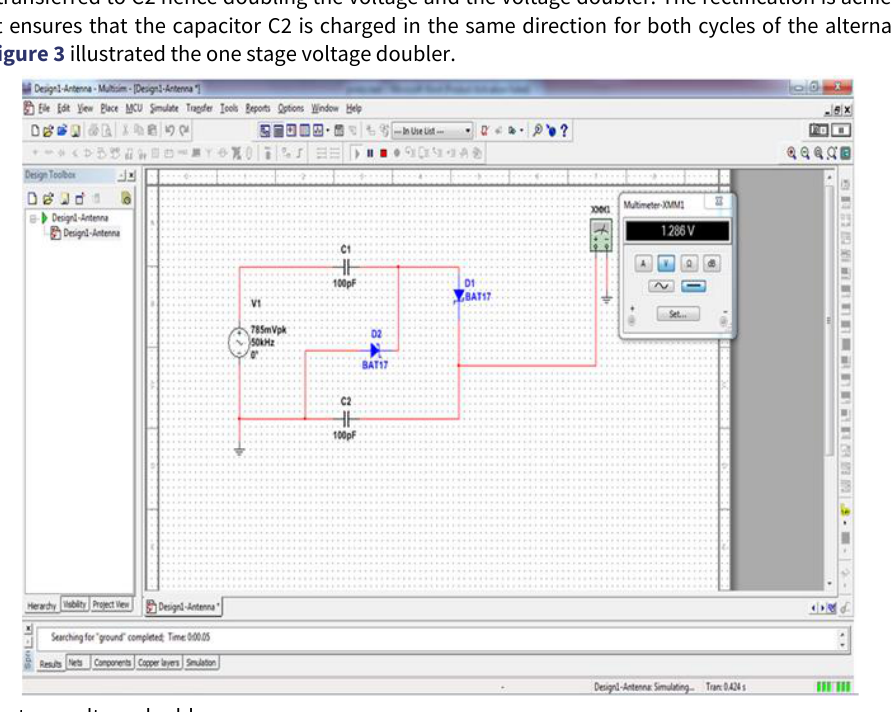
Figure 3. The one stage voltage